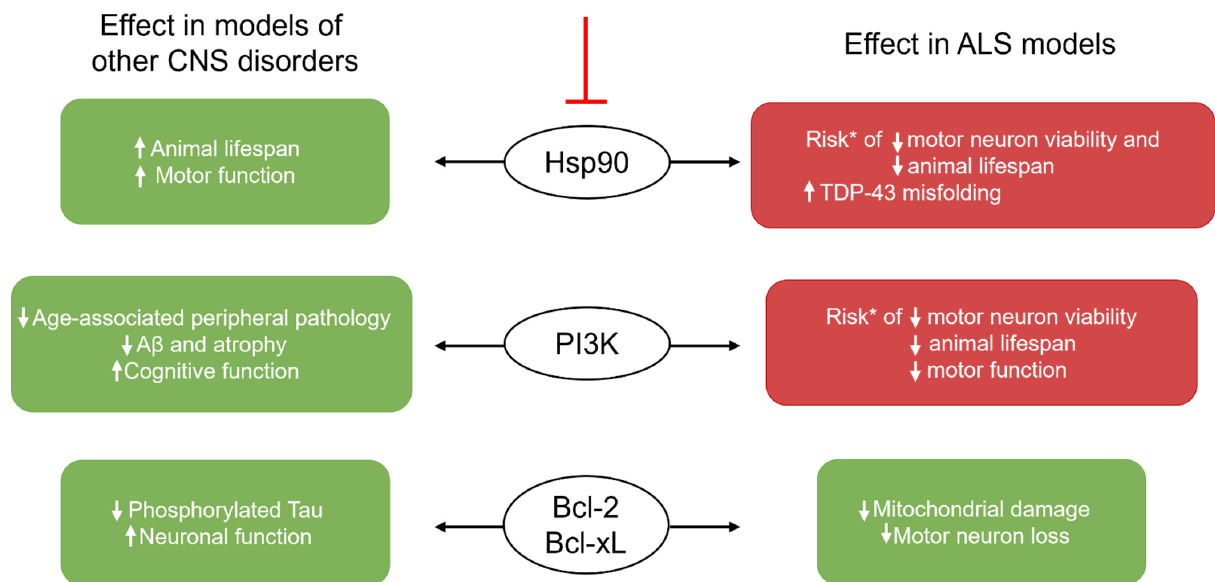
Figure 2. The effects of inhibiting current senolytic targets in non-ALS and ALS models. Blunted red line indicates inhibition. Red boxes and green boxes represent damaging and beneficial effects, respectively. ↑ denotes increase/improvement; ↓ denotes decrease. *Risk is based on the opposite effect occurring when Hsp90 or PI3K is activated. ALS: amyotrophic lateral sclerosis; Hsp90: heat shock protein 90; PI3K: phosphoinositide 3 kinase; Bcl-2: B-cell lymphoma 2; Bcl-xL: B-cell lymphoma extra-large.